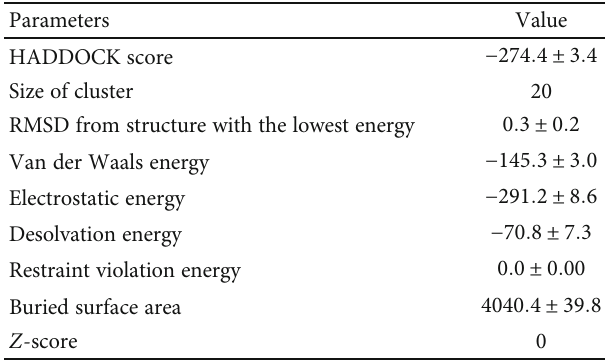
Table 4: Statistics of a single cluster obtained after applying re fi nements on top-ranked docked vaccine-TLR3